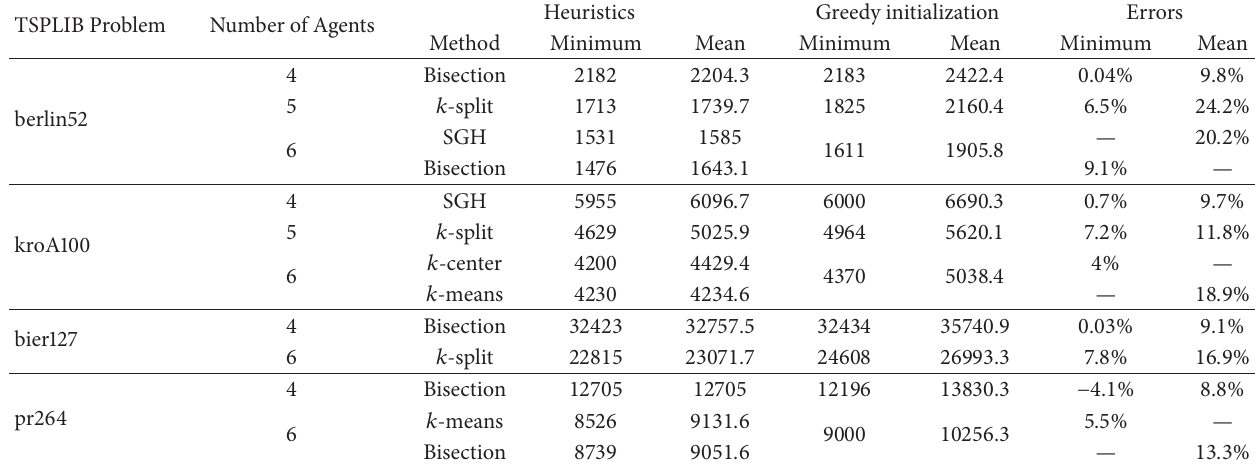
Table 2: Heuristics comparison for 100 simulations. The greedy initialization method was used.